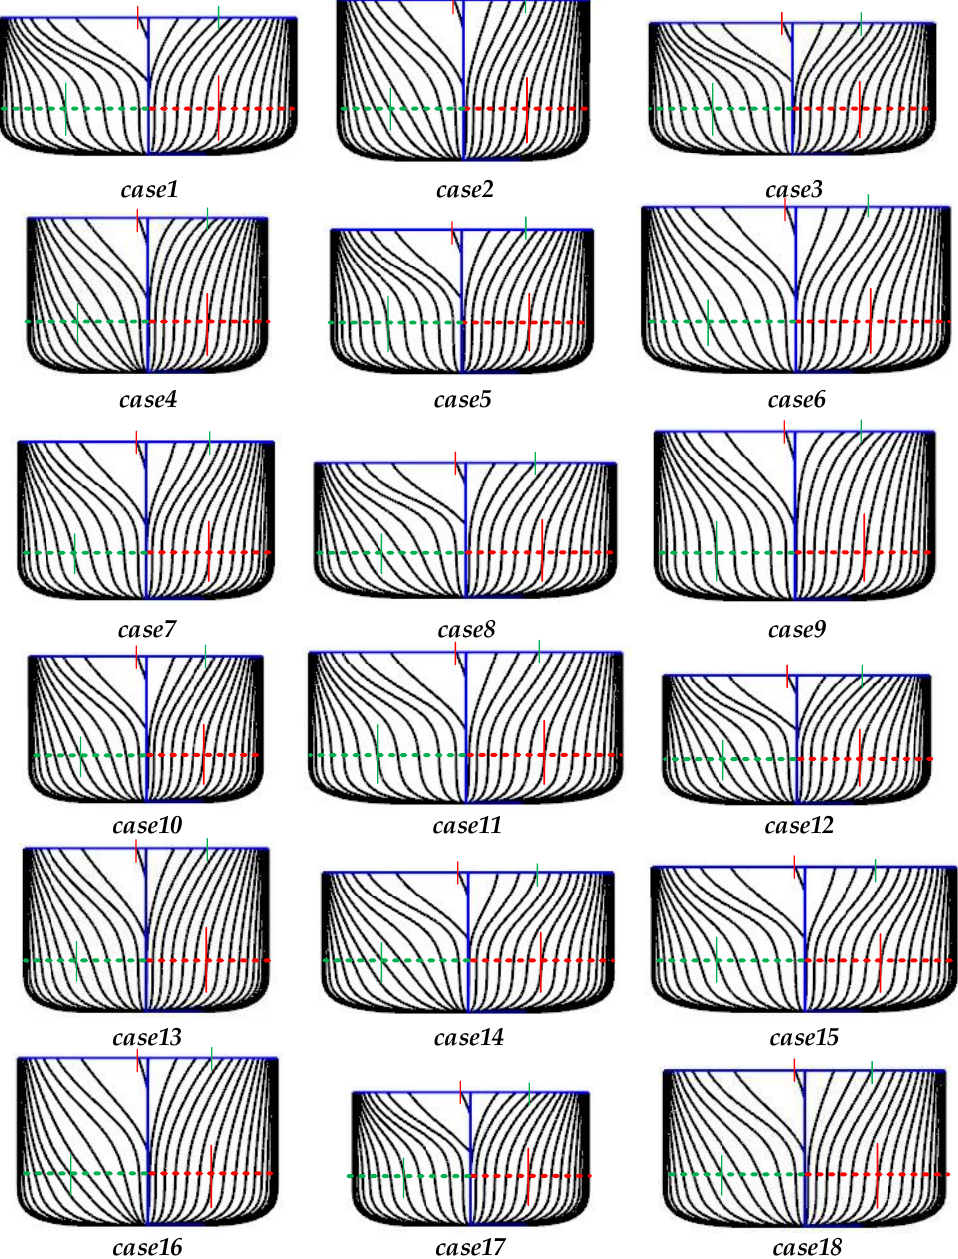
Figure 23. Schematic diagram of hull cross-section lines in each case. The dashed green and red lines indicate the waterline, the solid green line indicates that the angle varies in each case, and the solid red line indicates that the angle is constrained in each case.